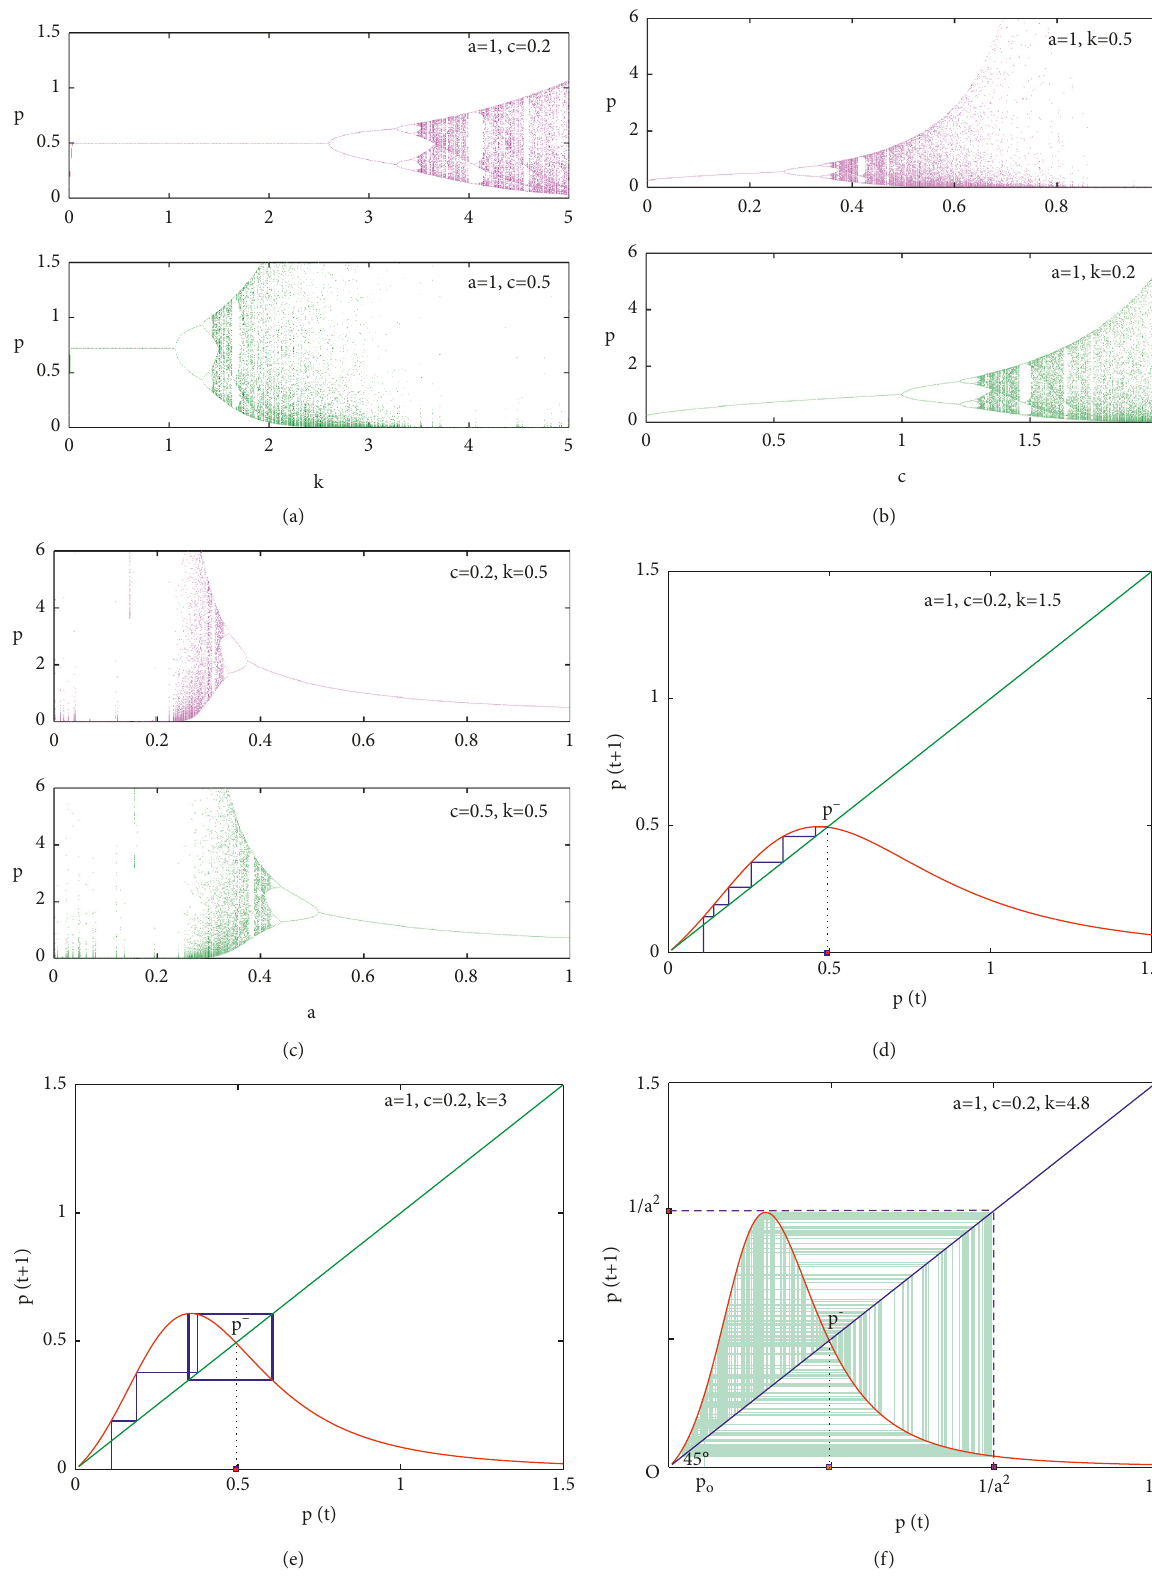
Figure 3: Bifurcation diagrams with respect to p on varying (a) k and a � 1 ,c � 0 . 2 , 0 . 5, (b) c and a � 1 ,k � 0 . 5 , 2, and (c) a and k � 0 . 5 ,c � 0 . 2 , 0 . 5 . Basin of attractions for different attracting set of the map (11) at the values (d) k � 1 . 5, (e) k � 3, and (f) k � 4 . 8. Other values are a � 1 , c � 0 . 2